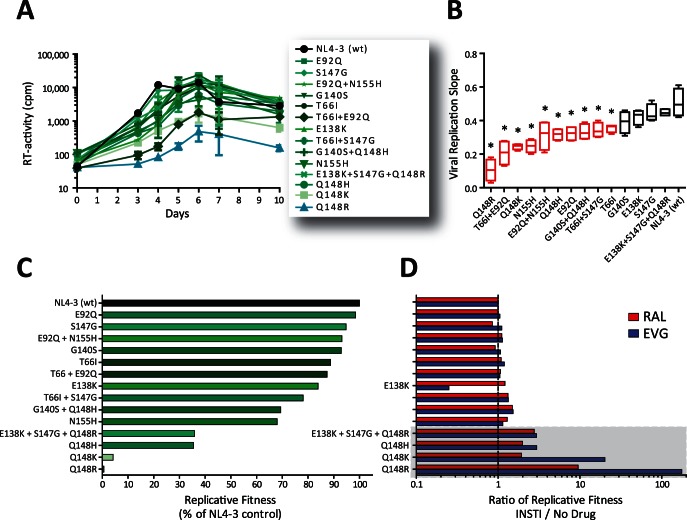
Replicative fitness of p2-INT-recombinant viruses carrying mutations associated with resistance to INSTIs in the absence and presence of EVG or RAL.(A) Fifteen p2-INT-recombinant viruses (i.e., 14 INSTI-resistance and the HIV-1NL4-3 wild-type virus) were evaluated for their ability to replicate in MT-4 cells in the absence of drug pressure. Virus replication was quantified by measuring reverse transcriptase (RT) activity in the cell-free supernatant. Error bars indicate the range of values obtained from three independent experiments. (B) Viral replication slopes were calculated using the slopes between RLU values at days 0 & 3, 0 & 4, 0 & 5, and 0 & 6. All four slope values for each virus were used to calculate the mean, standard deviation, and 10th & 90th percentiles. Differences in the mean values were calculated using a One Way Analysis of Variance test and the significance difference from HIV-1NL4-3 calculated using the Bonferroni’s Multiple Comparison Test. The replication kinetics of viruses marked with an asterisk (*) were significantly different from the HIV-1NL4-3 control (p<0.05, 95% CI). Each p2-INT-recombinant virus was competed against the HIV-1NL4-3 control in the absence (C) or presence (D) of EVG (0.01 nM) or RAL (1 nM) and their replicative fitness calculated and expressed as a percentage of the replicative fitness of the reference virus (HIV-1NL4-3) as described [55], [69]. The Ratio of Replicative Fitness was calculated dividing the % Replicative Fitness in the presence of drug (EVG or RAL) by the % Replicative Fitness in the absence of drug pressure; e.g., 105.5% ÷ 0.6% = 176x, for Q148R. Values represent results obtained from single growth competition experiments.